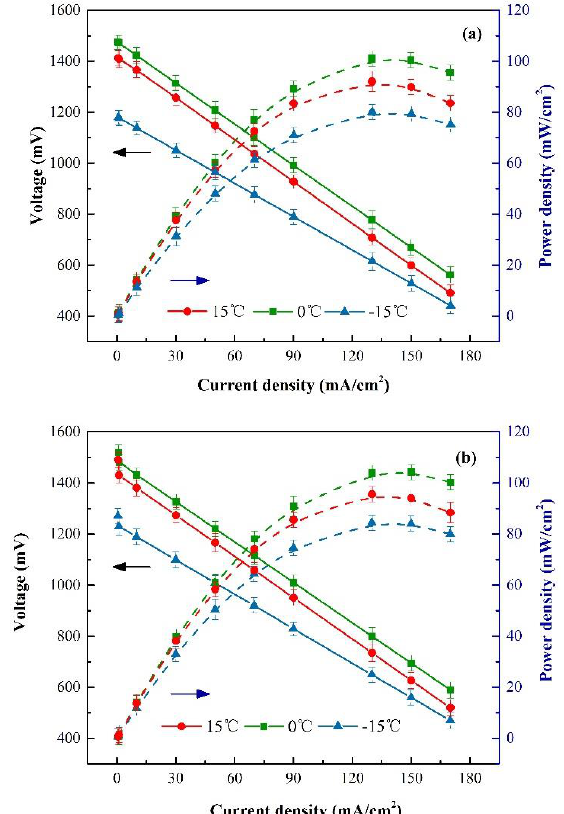
Figure 7. Discharging voltage and power density profiles versus current density with 25 wt%: ( a ) and 31 wt%; ( b ) KOH electrolyte solutions.